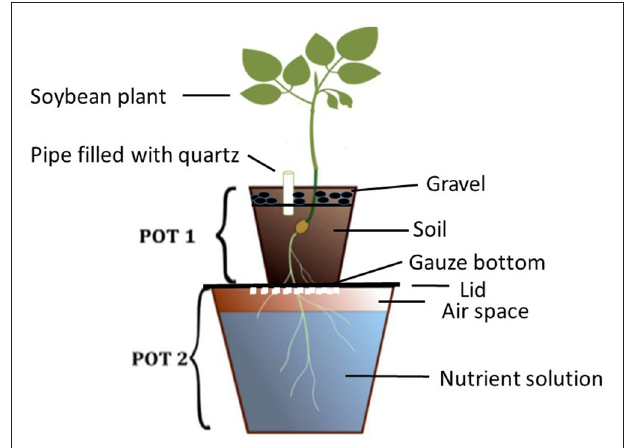
FIGURE 1 | Illustration of the setup of the double pot